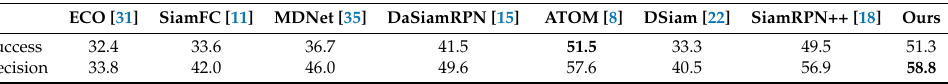
Table 4. Experimental results of our algorithm and other algorithms on the LaSOT dataset. The bolded values in the table are the best